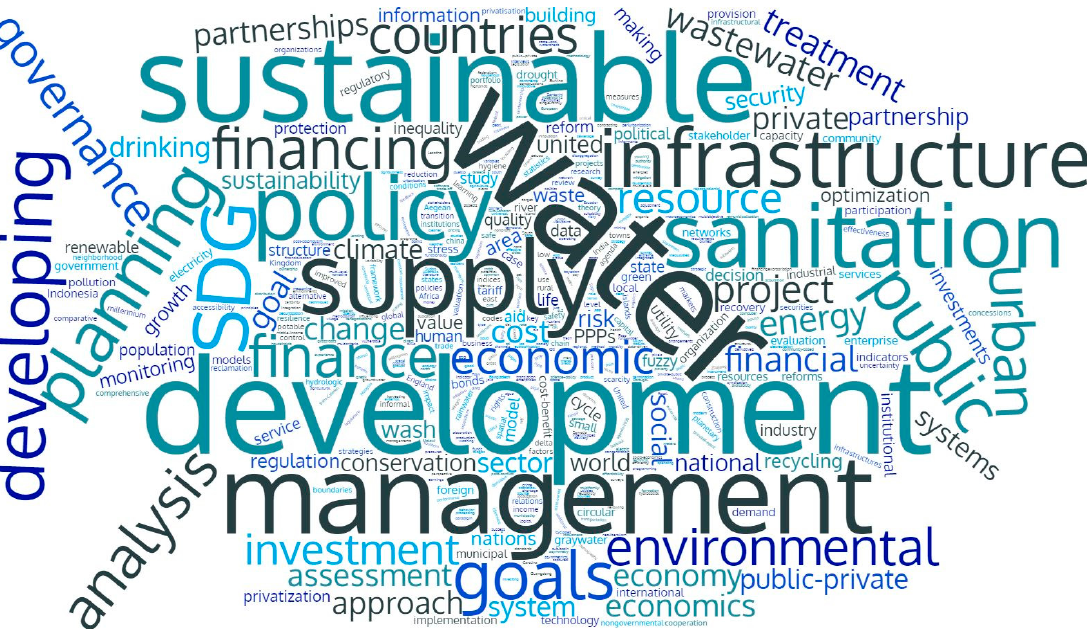
Figure A5. Research topics’ word cloud—2010s.